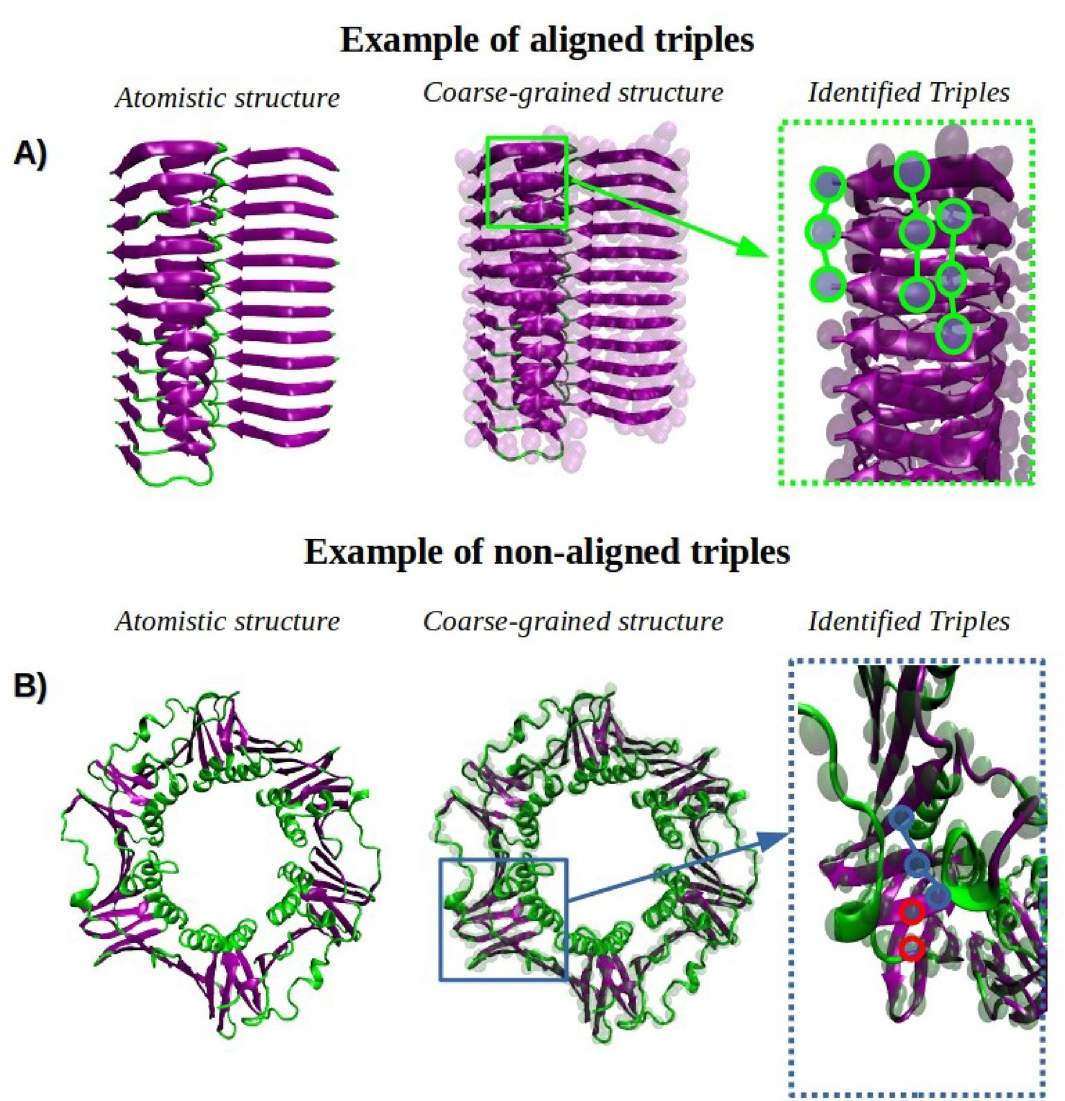
Figure 7. Examples of two real structures showing aligned/not-aligned triples. Green circles: aligned triples. Red circles: grains not belonging to any triples. Blue circles: non-aligned triples. HyperBeta has been validated against different protein structures (see Fig. 2). As shown in panel A, the 42-residue β -amyloid fibril consists of 12 parallel β -strands, resulting into aligned triples. Instead, as shown in panel B, the E. coli β -clamp is a ring-shaped homodimer characterized by different secondary structure arrangements. The complex topology, consisting of β -sheets and α -helix domains, hampers the identification of aligned